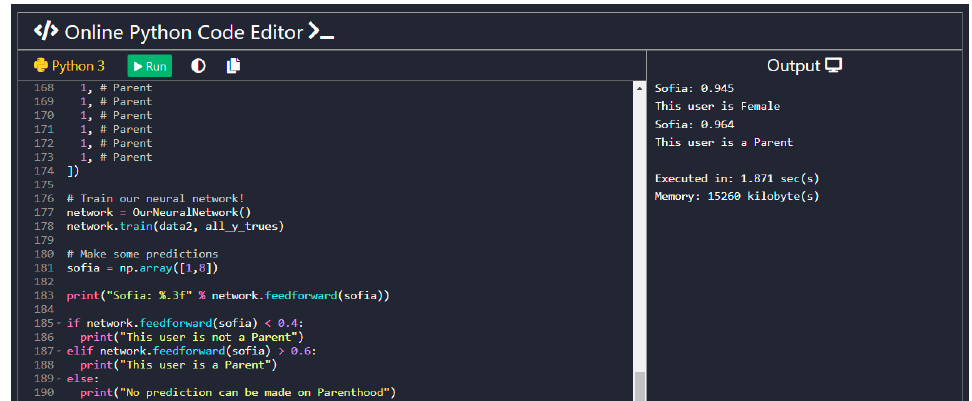
Figure 6. Prediction for a user. This user is a female and a Parent.